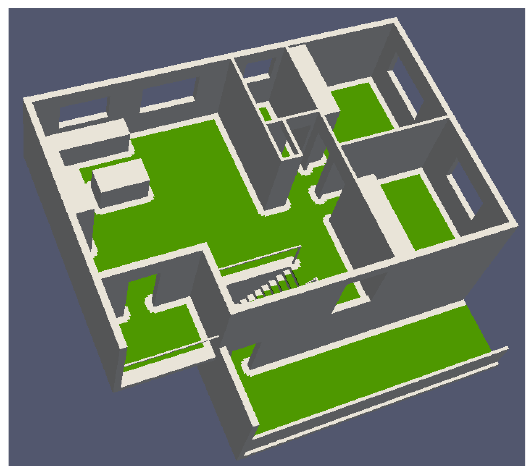
Fig. 1: Apartment voxel model after identifying navigable floor space.